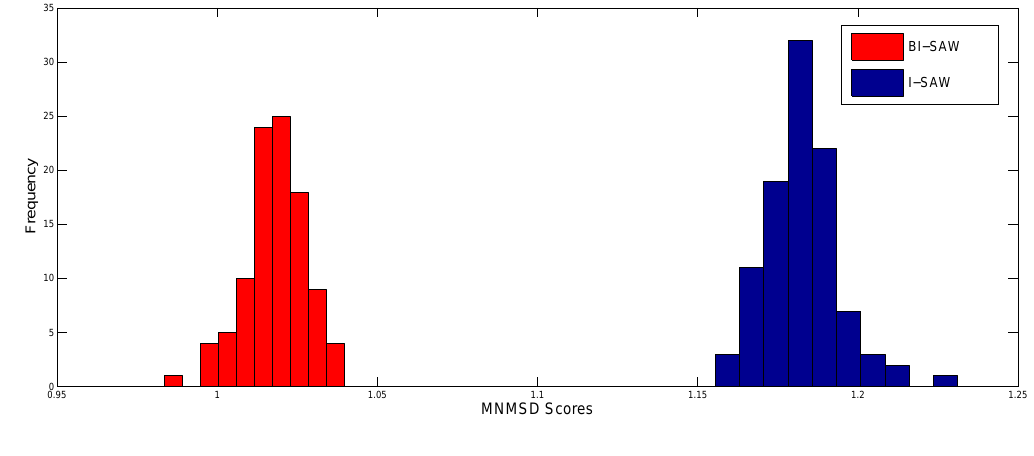
Figure 2. The distribution of MNMSD scores for the I-SAW and BI-SAW